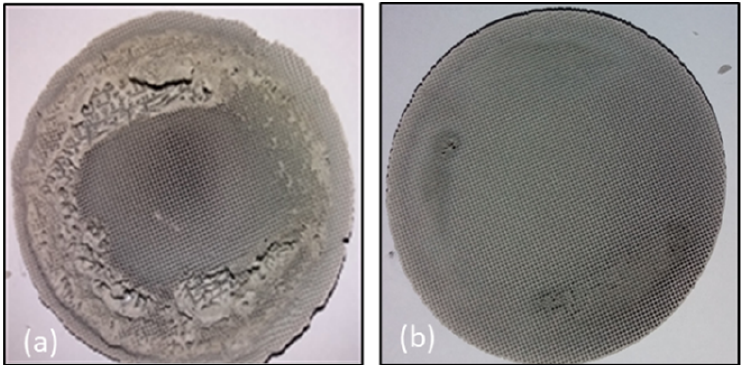
Figure 1. Picture of the exhausted TWC employed in this work: ( a ) engine exhaust gas outlet section; ( b ) monolith sampling section (M).